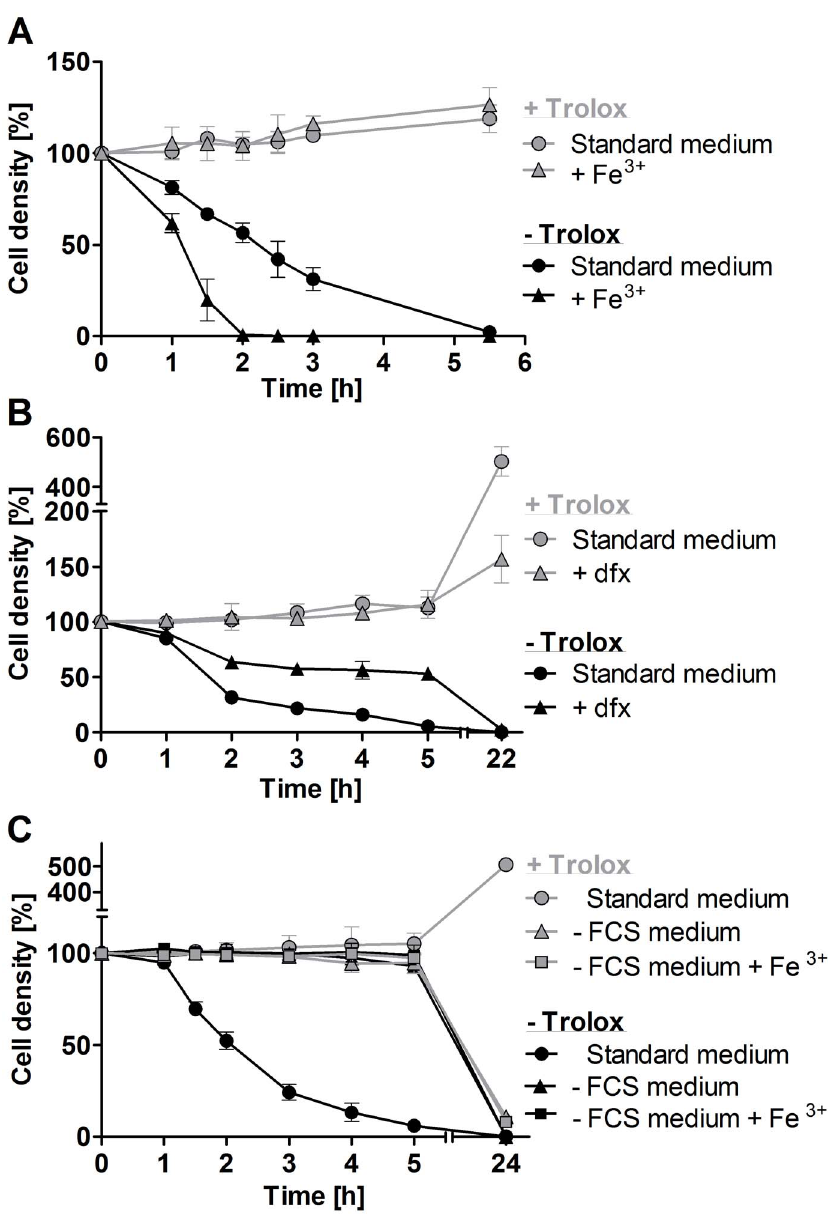
Figure 3. Exogenous iron promotes lysis of the pxI–II 2 / 2 BS cells. A. The mutant parasites were incubated for up to 5.5 h at 19 u C in standard medium 6 100 m M Trolox in the presence and absence of 100 m M Fe 3 + . WT cells behaved like the mutant cells in the presence of Trolox. B. The px I– II 2 / 2 cells were incubated for 5 h at 22 u C and then cultured overnight at 37 u C in medium 6 100 m M Trolox in the presence and absence of 100 m M deferoxamine (dfx). WT behaved like the mutant cells in the presence of Trolox. C. The px I–II 2 / 2 cells were incubated for 5 h at 19 u C and then cultured overnight at 37 u C in medium 6 10% FCS and/or 100 m M Trolox in the presence and absence of 100 m M Fe 3 + . The behavior of WT cells in the absence of FCS was identical to that of the mutant cells. At the different time points, living cells were counted. The values represent the mean 6 SD of three independent experiments.